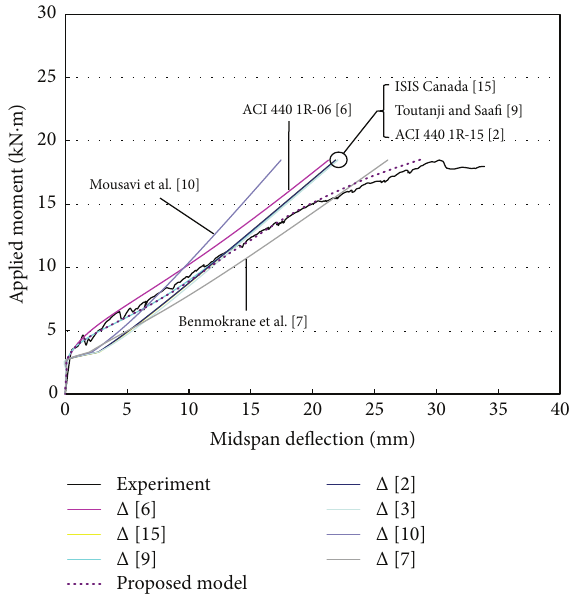
Figure 7: Moment-midspan deflection of FB-2.